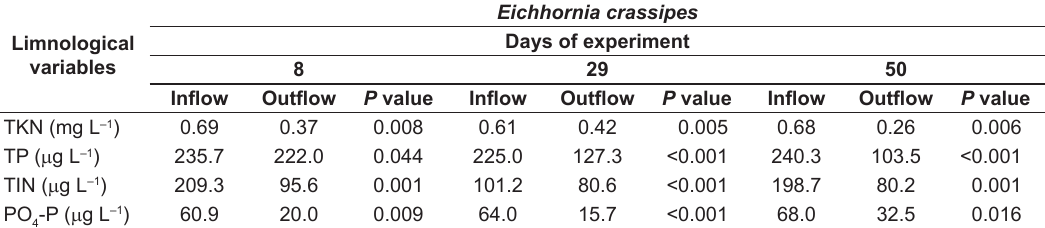
Table 1. Mean nitrogen and phosphorus concentrations in the inflow and outflow of tanks with Eichhornia crassipes resulting from the